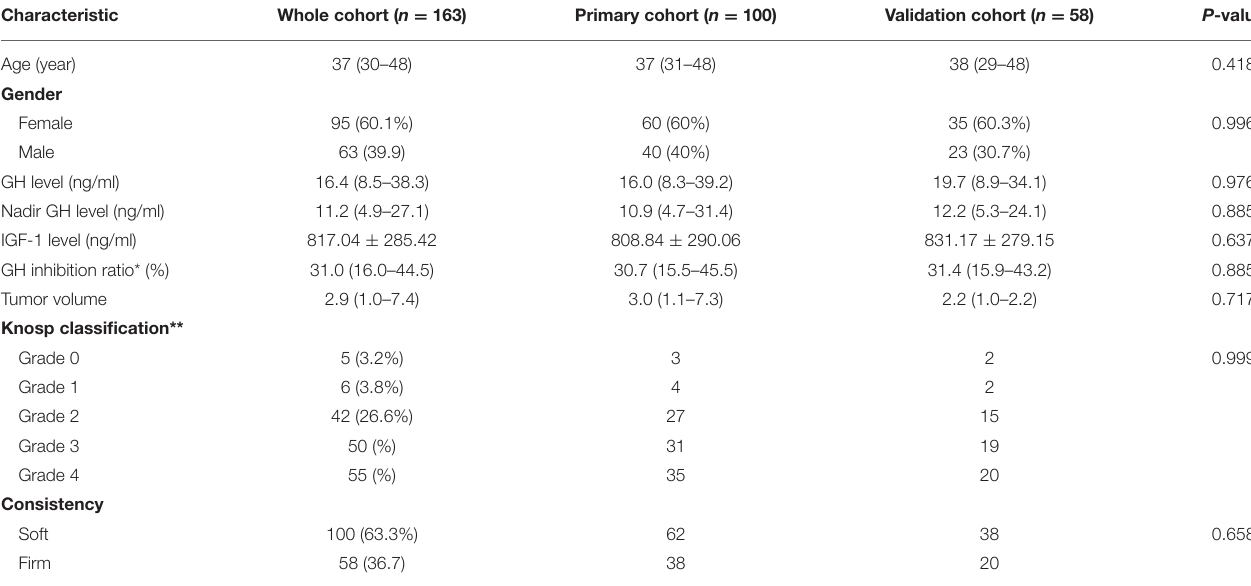
TABLE 1 | Characteristics of patients in the primary and validation